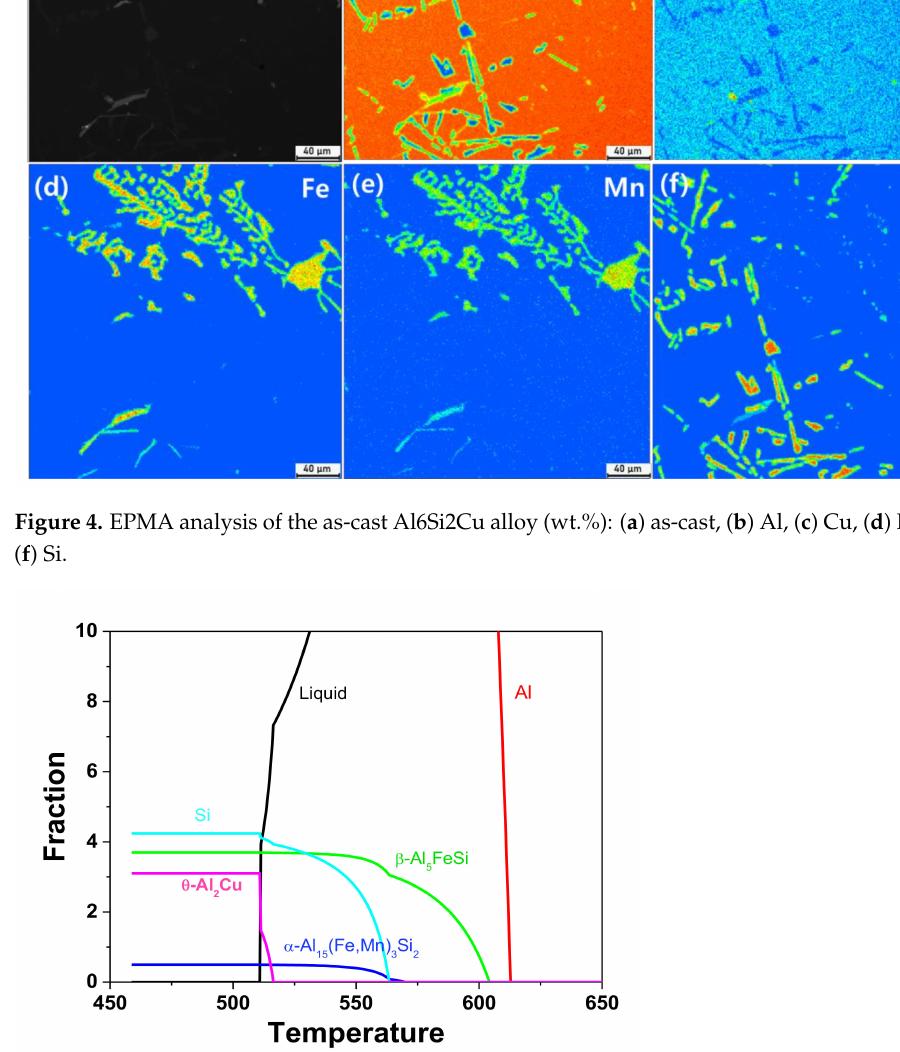
Figure 5. Mass–fraction of the equilibrium phase diagram of the Al6Si2Cu alloy computed through thermo-calc calculation showing the α and β Fe-rich phase, Cu-rich phase, and Si